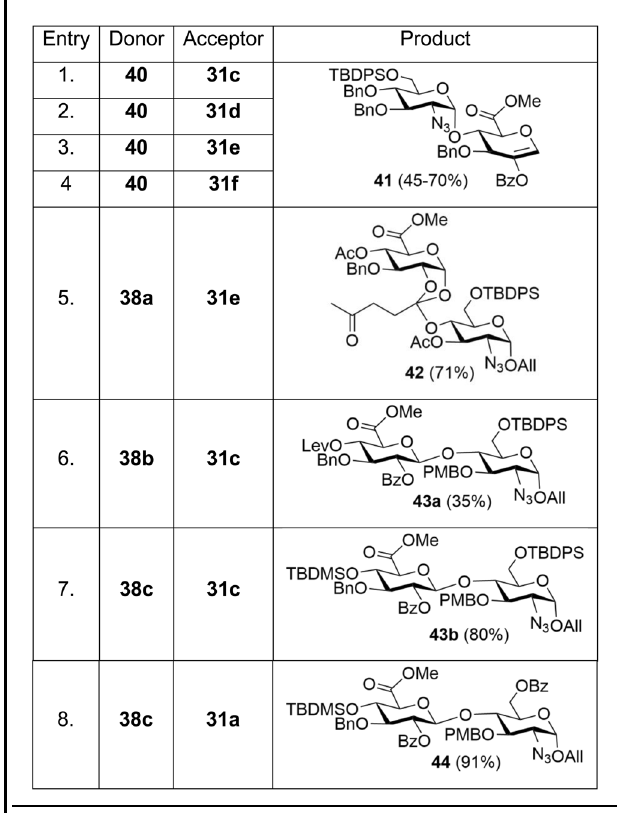
Table 2 Studies on glucuronic acid